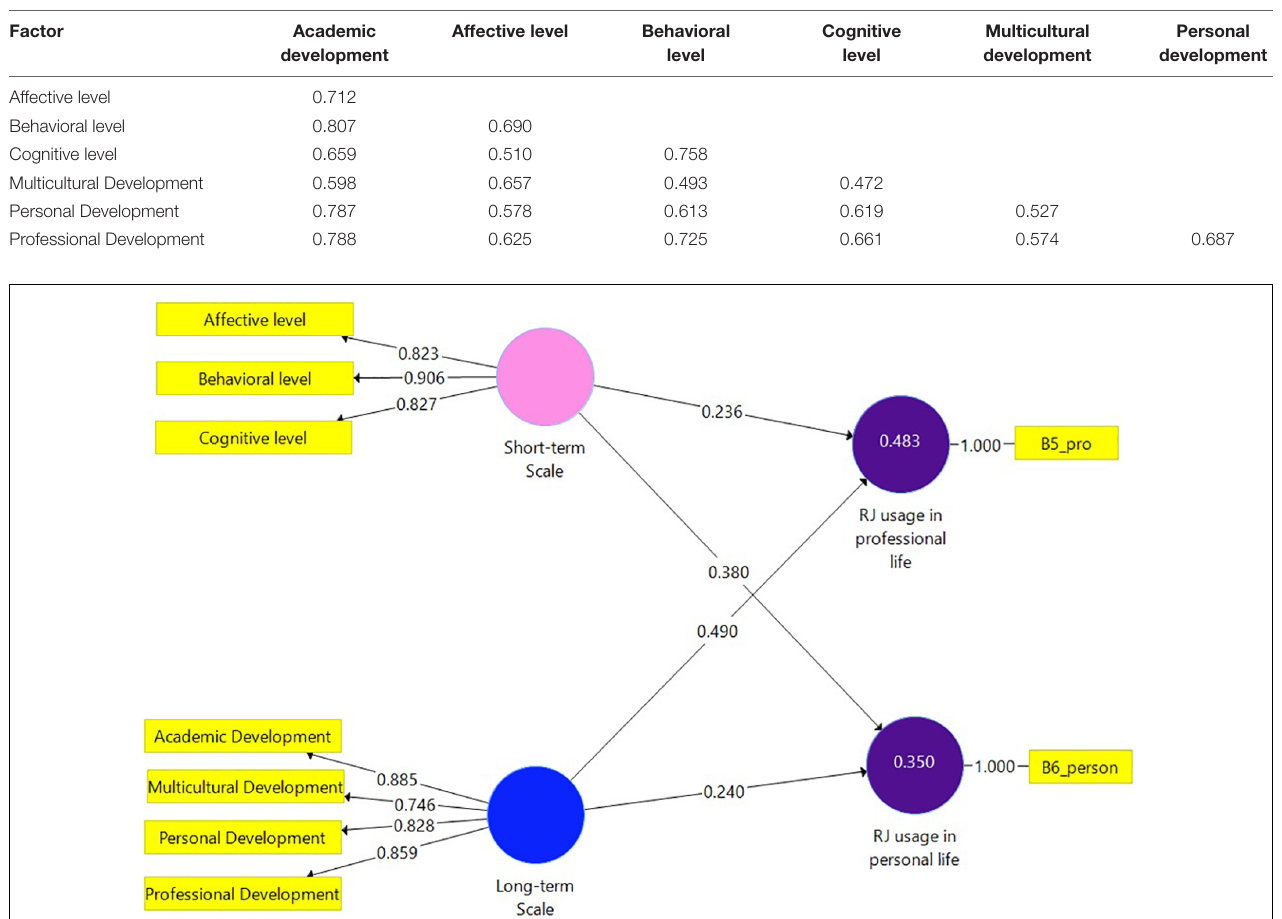
FIGURE 2 | Model 2. Analysis results of the examination of the research hypotheses by SmartPLS ( N = 141).